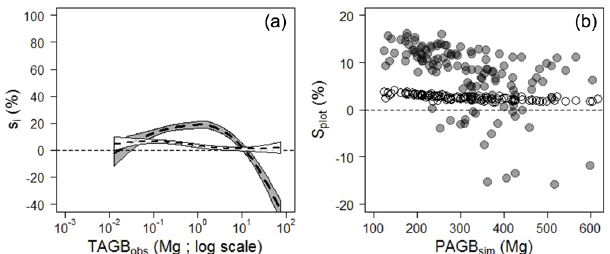
Figure 4. Panel (a) : relative residuals ( s i , in %) of the reference biomass allometric model m 0 (grey background) and our model m 1 including crown mass (white background). Thick dashed lines rep- resent fits of local regressions (loess function; span: 1) bounded by standard errors. Panel (b) : propagation of individual estimation er- rors of m 0 (solid grey circles) and m 1 (empty circles) to the plot